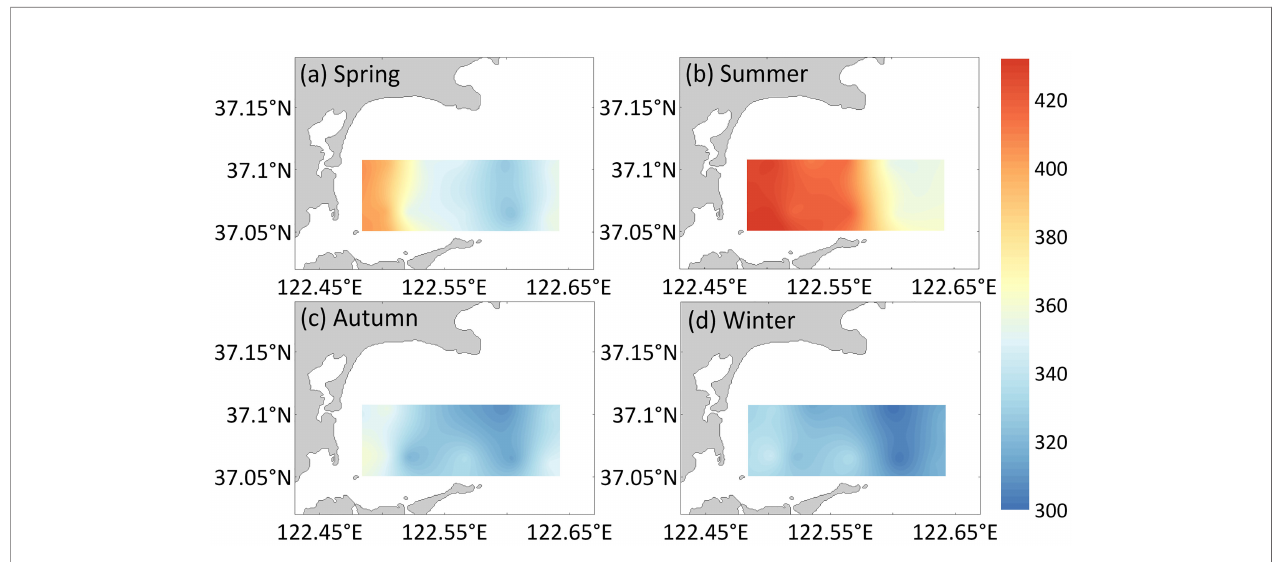
FIGURE 3 | Horizontal distribution of p CO 2 ( m atm) for the (A) spring, (B) summer, (C) autumn, and (D) winter surface water in Sanggou